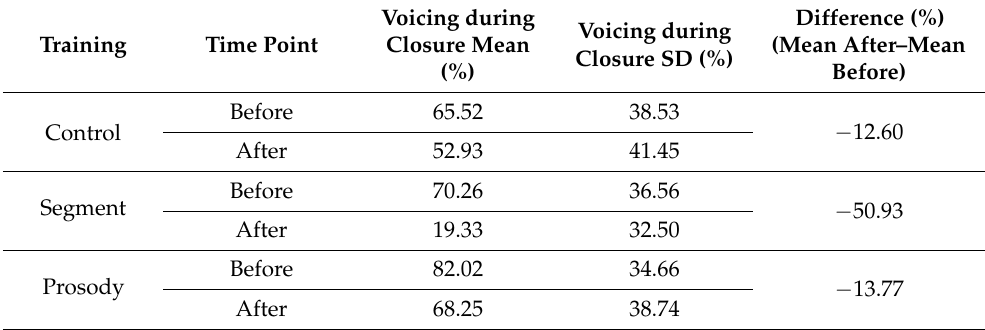
Table 10. Voicing during closure